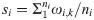
All fields Likert chart: 5500 respondents.The number of responses less than zero on the x-axis include almost never (ω0), sometimes (ω1) and half of the often (ω2) responses. The number of responses greater than zero include almost always (ω4), usually (ω3), and half of the often responses. The mean scores on the y-axis are si=Σ1niωi,k/ni and varies from a low of 0.7 (troubleshooting) to a high of 3.7 (drafting).